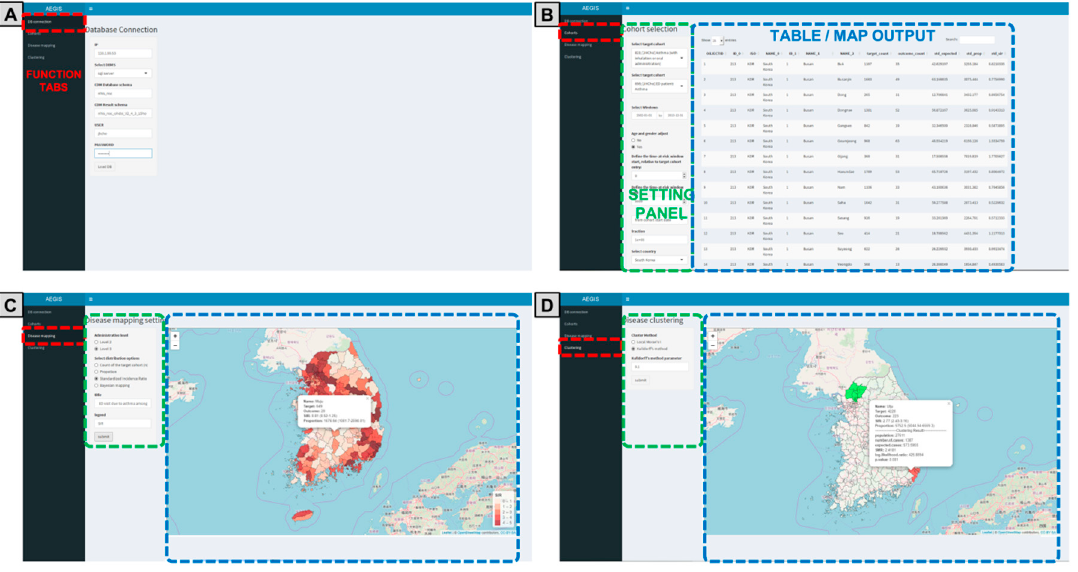
Figure 2. Graphical user interface of AEGIS. Four function tabs (red box), setting panel (green box), and table and map outputs (blue box). AEGIS, Application of Epidemiological Geographic Information System.